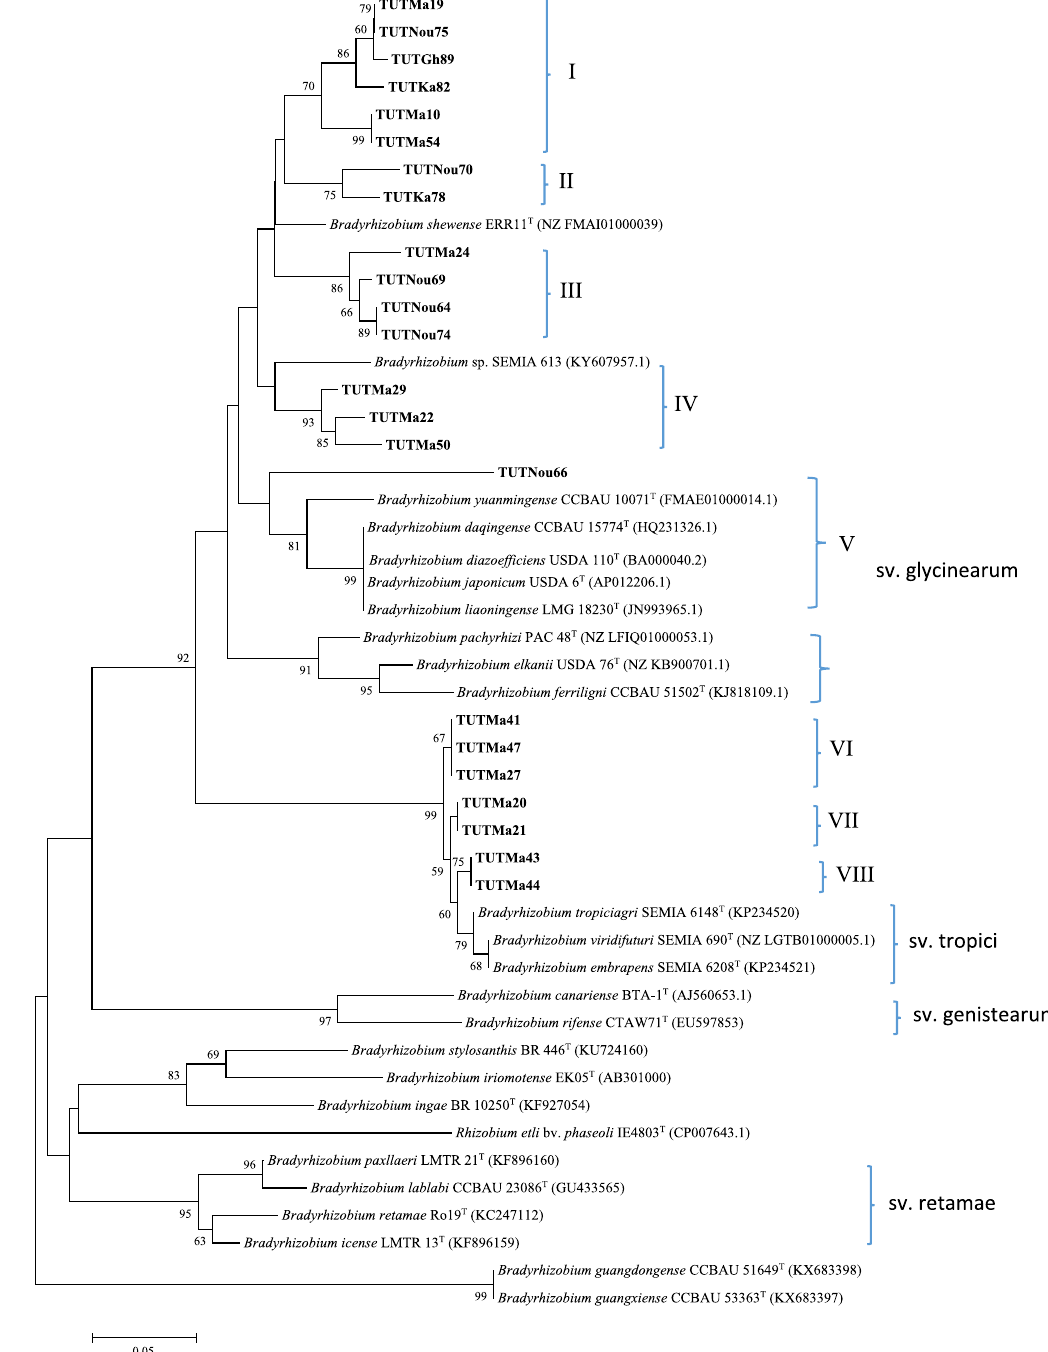
Figure 6. Phylogenetic tree based on nodC gene sequences generated by Maximum likelihood method. Bootstrap values (1000 replicates) are indicated above the branches which shows the percentage of trees in which the associated taxa clustered together. The number of nucleotide substitution is indicated by scale bar. All missing and gap nucleotide sequences were eliminated during phylogenetic tree construction. Evolutionary analyses were conducted in